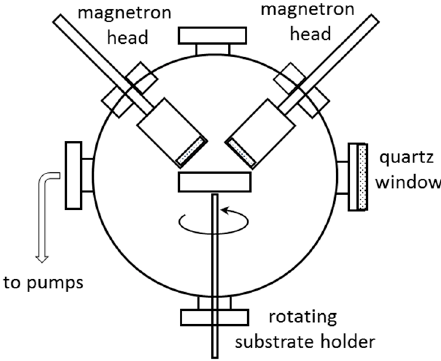
Figure 1. Experimental set-up for polytetrafluorethylene (PTFE) / Ag / PTFE nanocomposites synthesis.